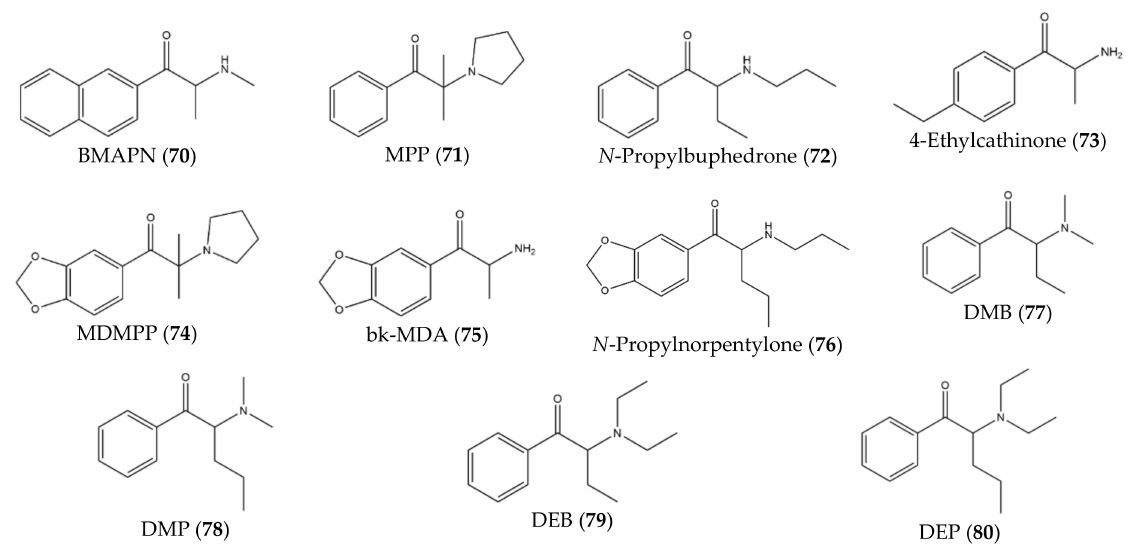
Figure 9. Structures of cathinone derivatives synthesized in controlled laboratories ( 70 )–( 80